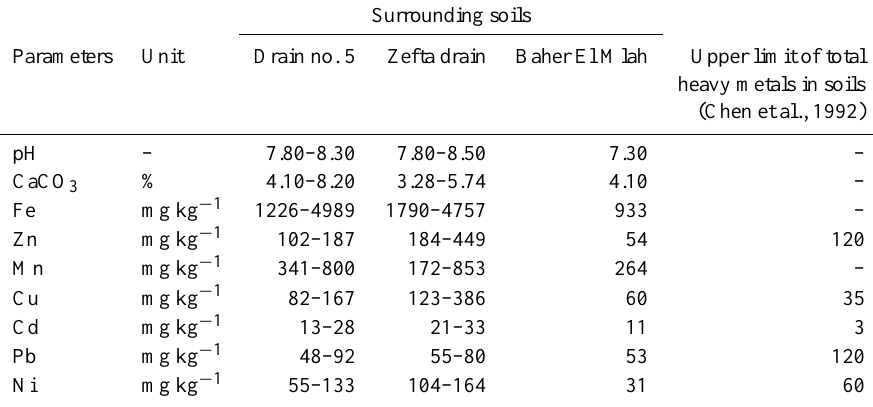
Table 1. Total concentrations of heavy metals in soils irrigated by contaminated water from Zefta drain, drain no. 5, and Baher El Mlah canal. Surrounding soils Parameters Unit